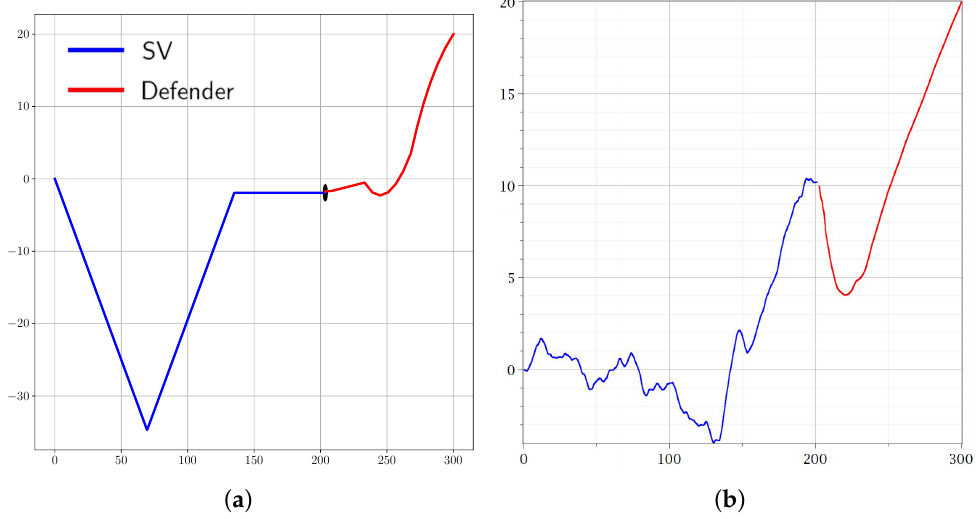
Figure 7. Destruction of the SV. ( a ) SV and defender trajectories corresponding to the path of θ t ; ( b ) SV and defender trajectories corresponding to the path of Θ t